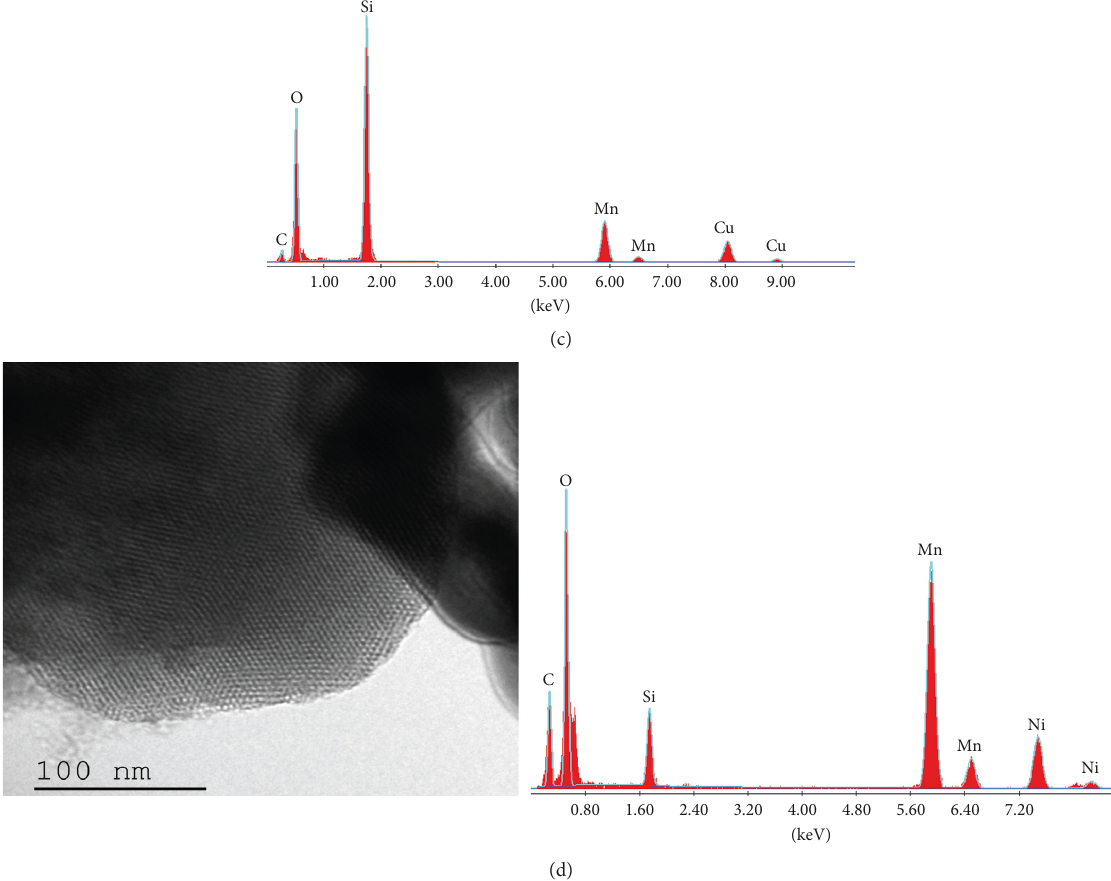
Figure 6: TEM images and EDX results of (a) MnLUS (30 wt.%).